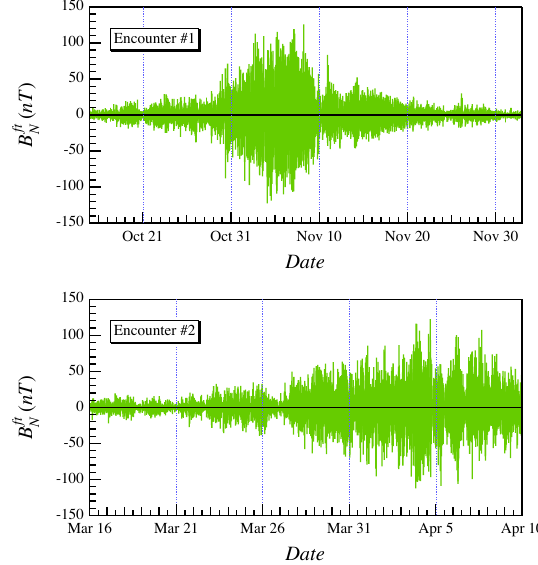
( t ) for both the first and the second N